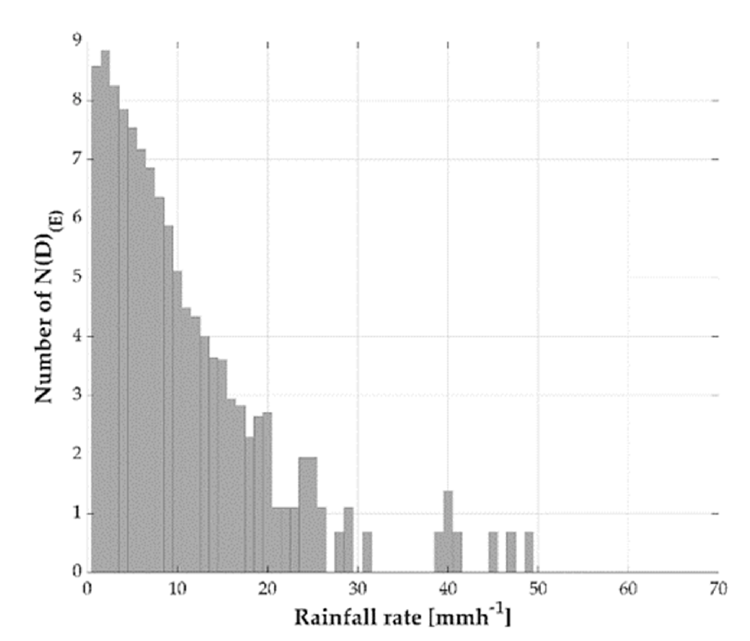
Figure 8. Semilog plot of the number of N(D) E falling in each rainfall intensity class.